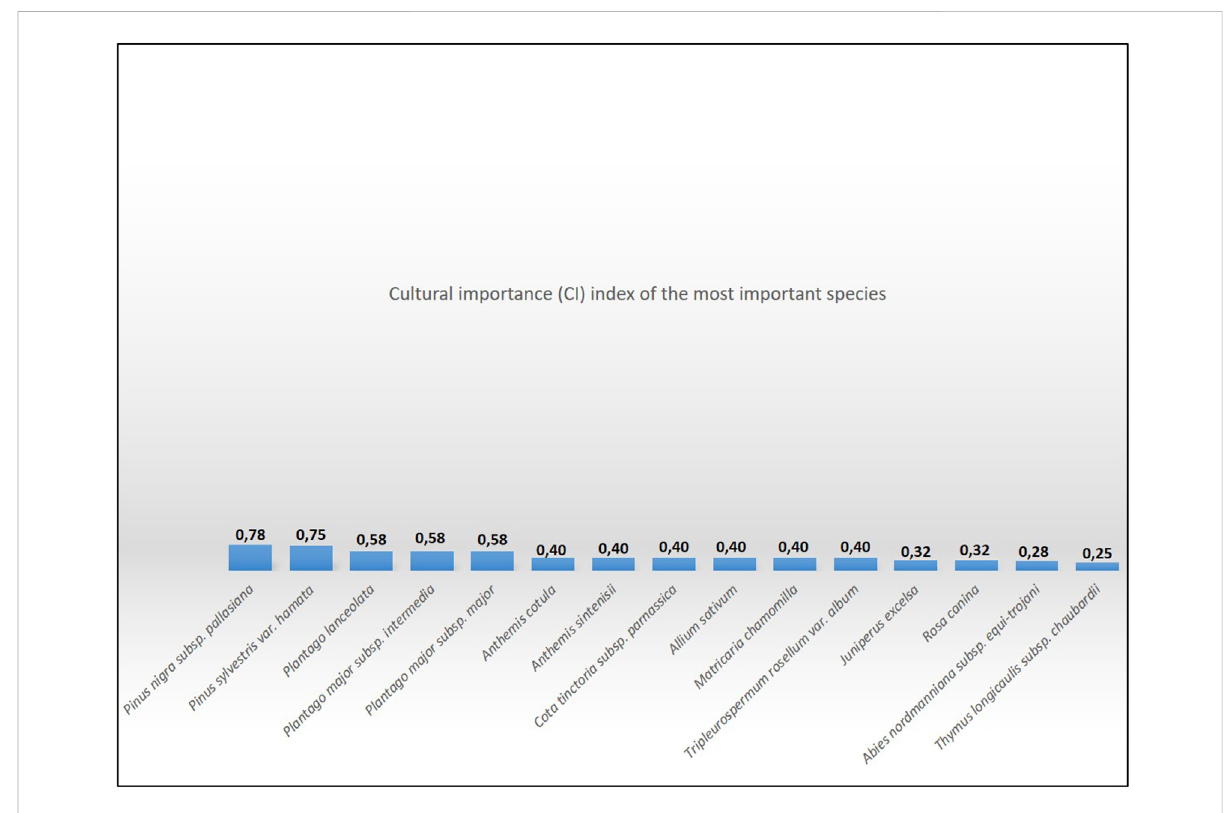
FIGURE 9 Cultural importance (CI) index of the 15 most important species in Ta ş